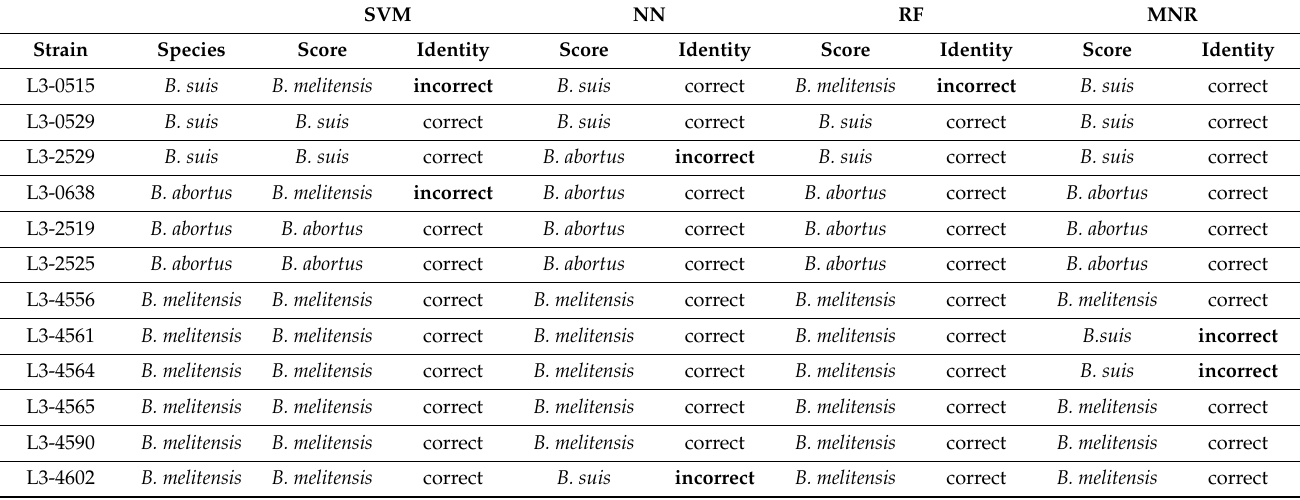
Table 3. Species assignment for each strain from the external dataset, performed by the optimized fine-tuned ML models trained on the top four features identified using a standard feature selection approach specific for Mulitnomial Logistic Regression (MNR), Random Forest (RF), Neural Network (NN) and Support Vector Machine (SVM), separately. Incorrect classification is shown in bold. SVM